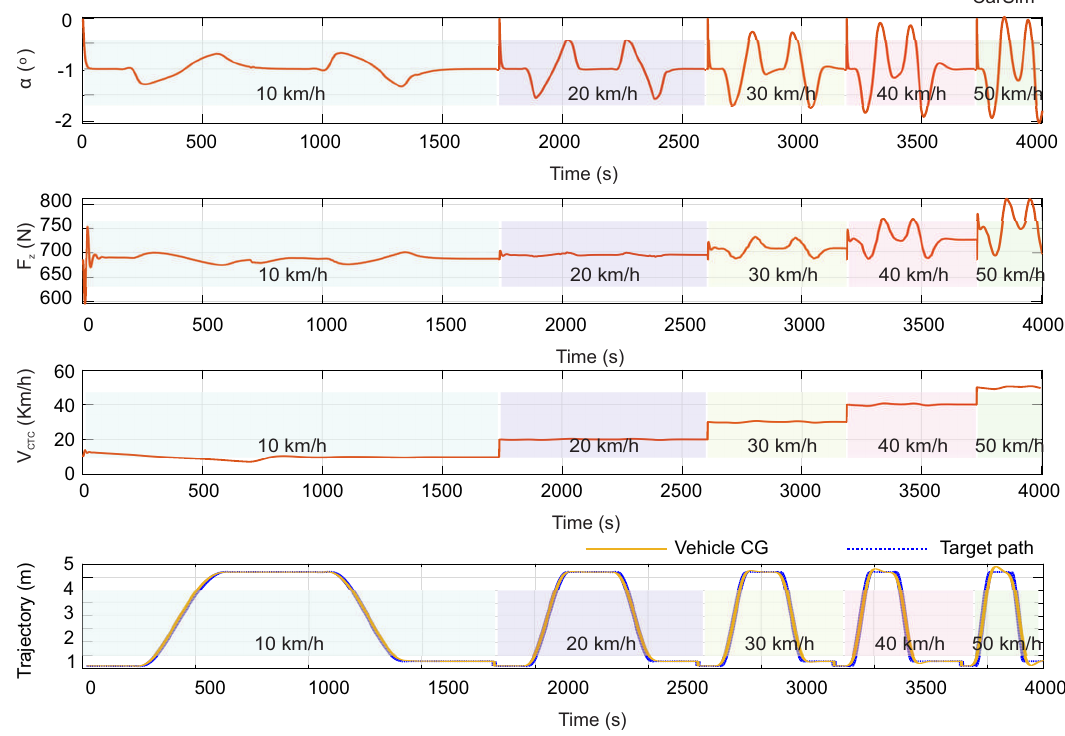
Figure 17. Inputs variables (CarSim variables - wheel L1) to test the estimator at complex